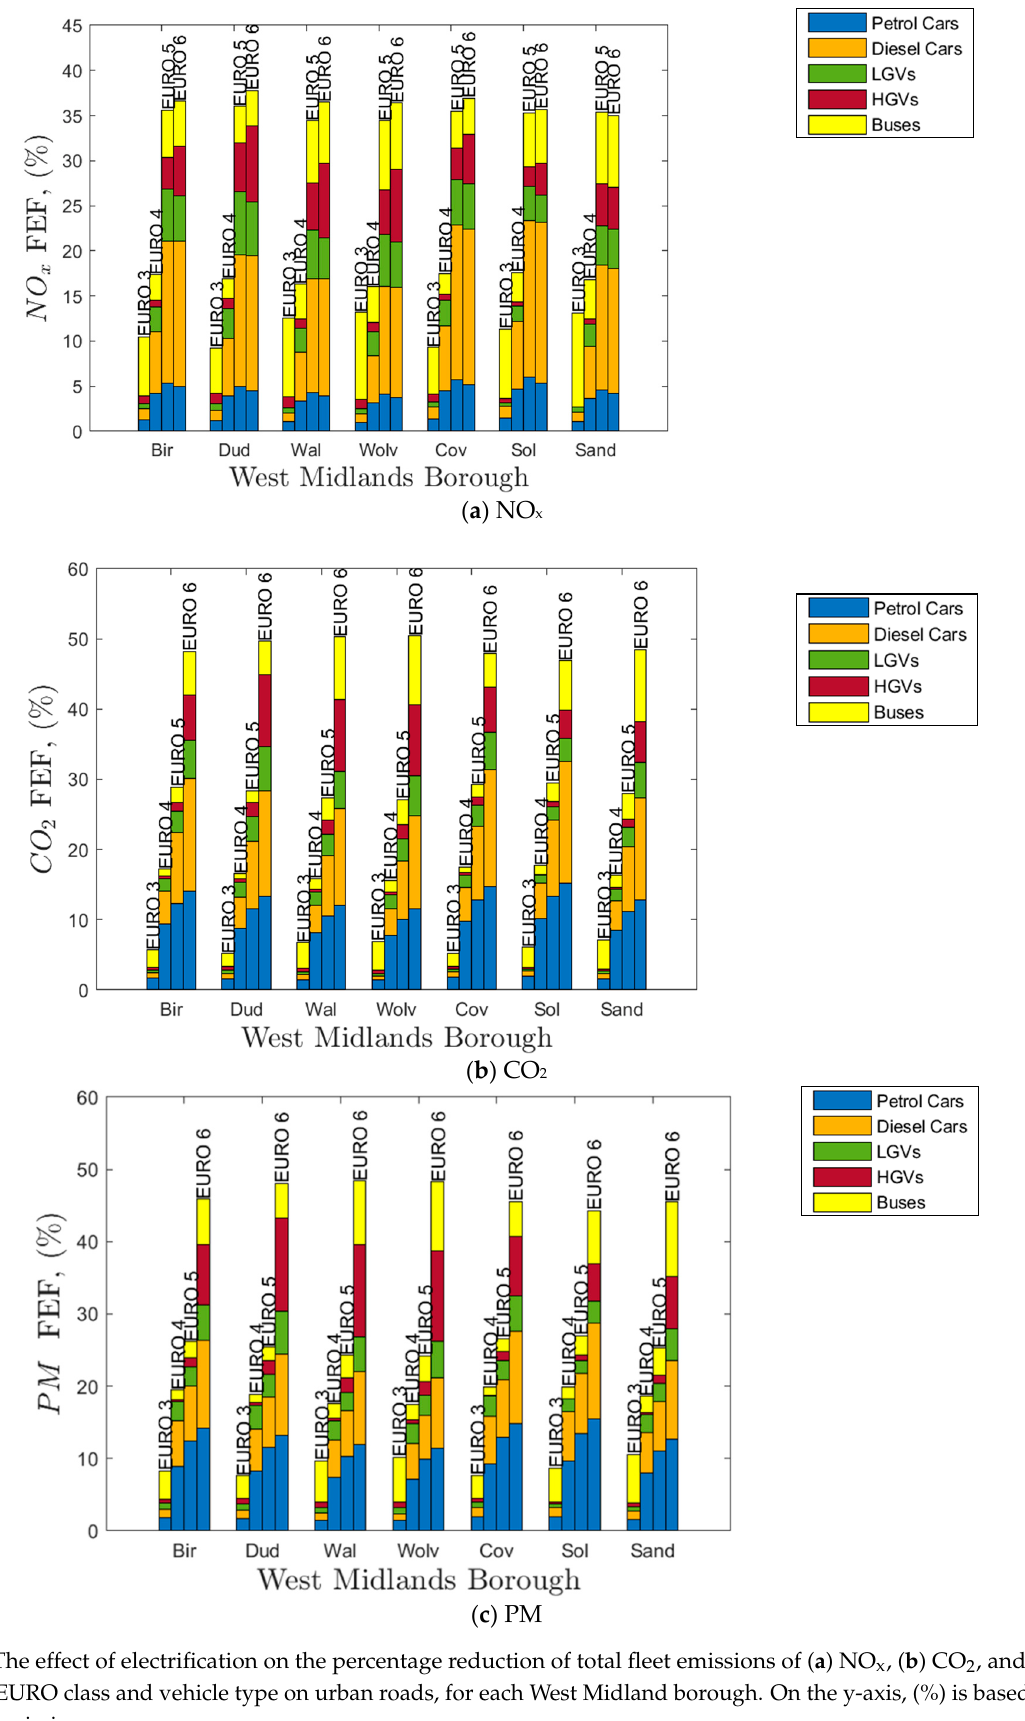
Figure 4. The effect of electrification on the percentage reduction of total fleet emissions of ( a ) NO x , ( b ) CO 2 , and ( c ) PM subset by EURO class and vehicle type on urban roads, for each West Midland borough. On the y-axis, (%) is based on the total fleet emission.